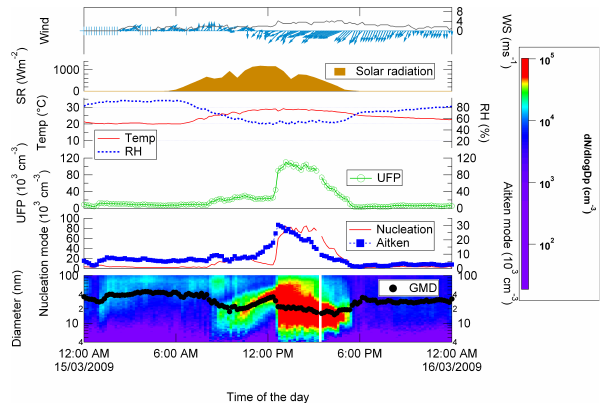
Fig. 12. Contour plot of particle size distribution observed on 15 March 2009. From bottom to top, the parameters are: (i) Ge- ometric median diameter (GMD) and contour plot of size distribu- tion; (ii) Particle number concentration of nucleation and Aitken mode particles; (iii) Particle number concentration of ultrafine par- ticles (UFP); (iv) Temperature and relative humidity; (v) Solar radi- ation; and (vi) wind direction and